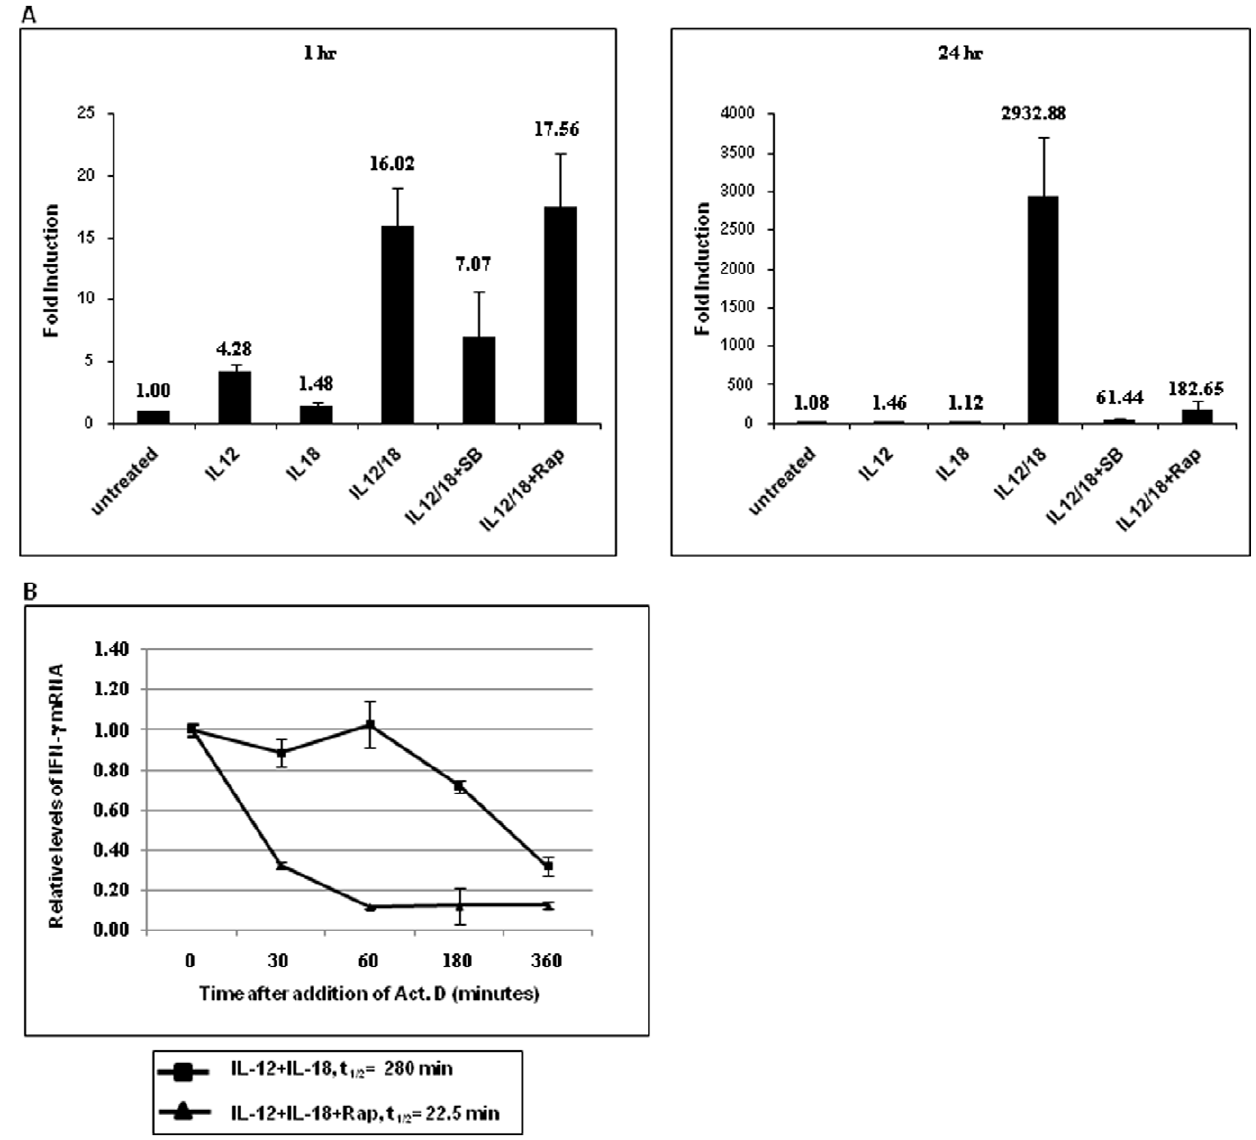
Figure 2. Effect of cytokine treatment on IFN- c mRNA levels. (A) Human peripheral blood CD4 + T cells were stimulated with IL-12 and/or IL-18 for either 1 hour (left panel) or 24 hours (right panel) in the presence or absence of rapamycin or SB203580. Total RNAs were isolated and analyzed by real-time PCR. The quantity of each cDNA was normalized by GAPDH. Data represent average 6 SD from triplicate. (B) Effect of rapamycin on IL-12 plus IL-18-induced IFN- c mRNA stability. Peripheral blood CD4 + T cells were stimulated with IL-12 plus IL-18 for 18 hours in the presence or absence of rapamycin. At 18 hours, actinomycin D (1 m g/ml) was added to stop new RNA synthesis, and the cultures were incubated further for various periods of times. After each point, total RNAs were isolated and analyzed by real-time PCR. The quantity of each cDNA was normalized by b -actin. Data represent average 6 SD from triplicate.